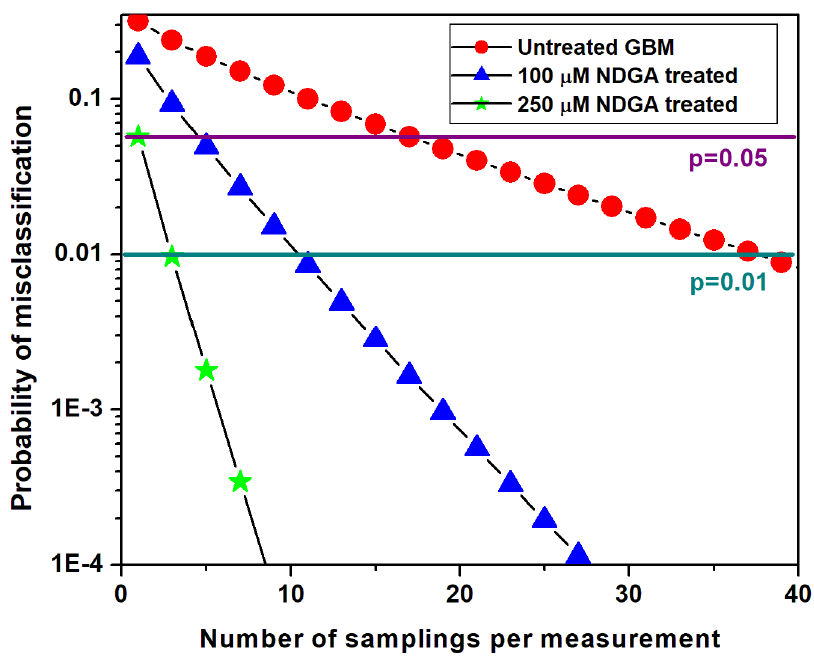
Figure 6. Probability of misclassification versus the number of randomly chosen spectra employed in the classification. The horizontal violet and dark cyan lines are for easier visualization of the sets of measured spectra sufficient to classify the samples with error probabilities of p = 0.05 and p = 0.01, respectively.